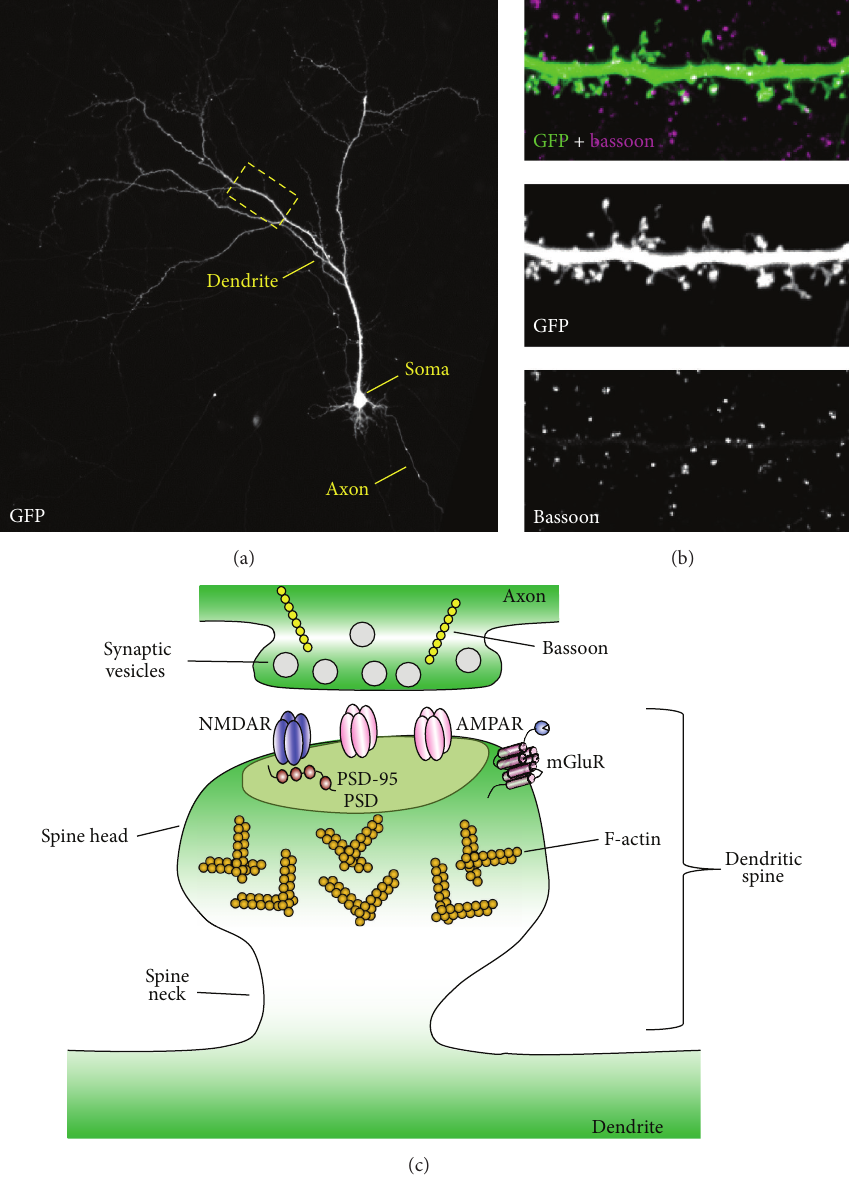
Figure 1: Dendritic spines are small protrusions along dendrites that contain postsynaptic densities. (a) Example of a cortical neuron expressing green fluorescent protein (GFP). The main dendrite is branched and has dendritic spines along its length. Dashed box indicates area magnified in (b). The neuron’s axon is much thinner than the dendrite and has no spines. (b) Magnified region of dendrite of a cortical neuron expressing GFP and stained for the presynaptic protein bassoon. Dendritic spines can clearly be seen protruding from the dendrite, and many spines colocalize with bassoon, suggesting the formation of synaptic connections. In this colour scheme, colocalization is indicated by white. (c) Schematic of a mature dendritic spine making contact with an axon; note the enrichment of glutamate receptors, the scaffold protein PSD-95, and F-actin within the spine head and postsynaptic density